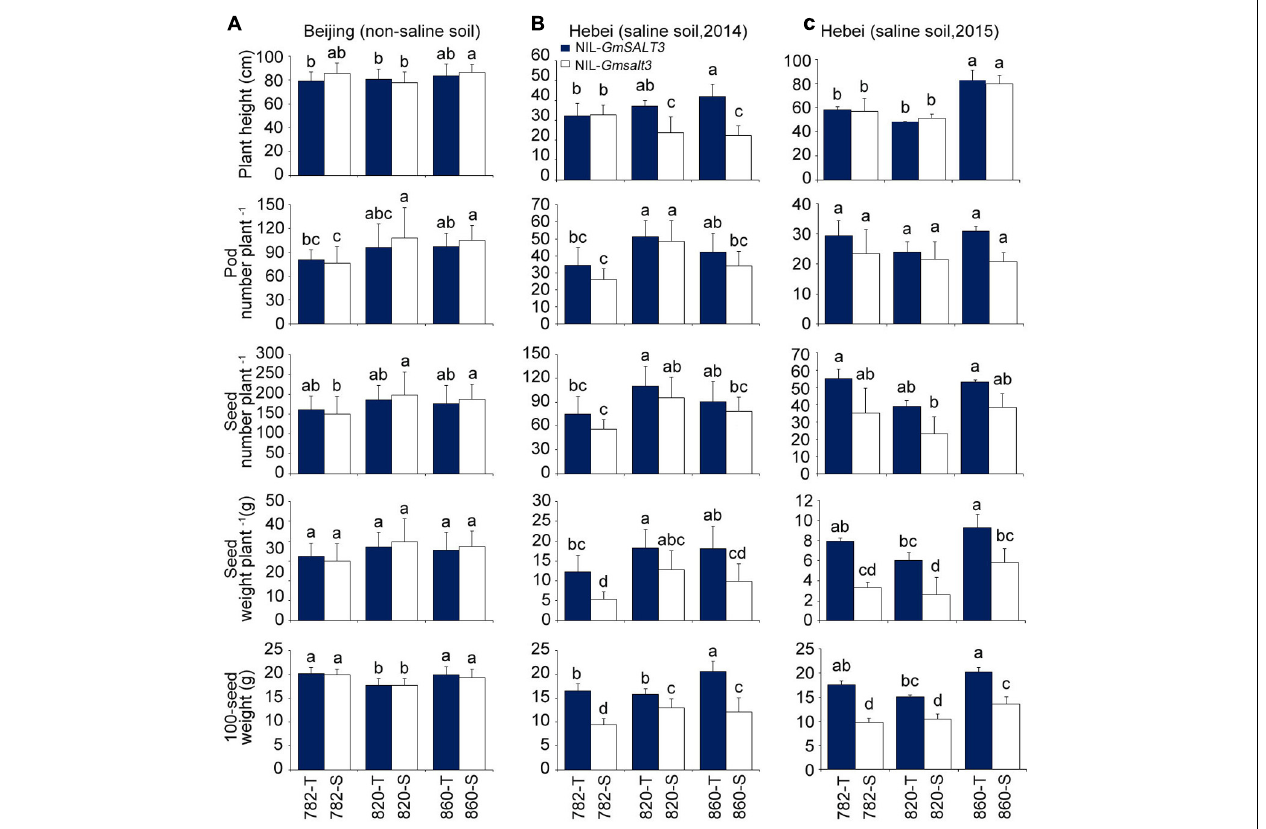
FIGURE 6 | Yield related traits comparison for three sets of NILs grown in saline and non-saline soil conditions. (A) Plant height, pod number per plant, seed number per plant, seed weight per plant and 100-seed weight of three sets of NILs grown in non-saline soil (Shunyi, Beijing). Data are means of three replicates consisting of mean data from 15 plants per replicate ± SD ( n = 3). (B) Plant height, pod number per plant, seed number per plant, seed weight per plant and 100-seed weight of three sets of NILs grown in saline soil (Tanghai, Hebei province, 2014). (C) Plant height, pod number per plant, seed number per plant, seed weight per plant and 100-seed weight of three sets of NILs grown in saline soil (Tanghai, Hebei province, 2015). Data are means of three replicates consisting of mean data from 15 plants per replicate ± SD ( n = 3). Different letters indicate statistically significant differences between NIL lines (one-way ANOVA followed by Tukey’s HSD post hoc test, P <